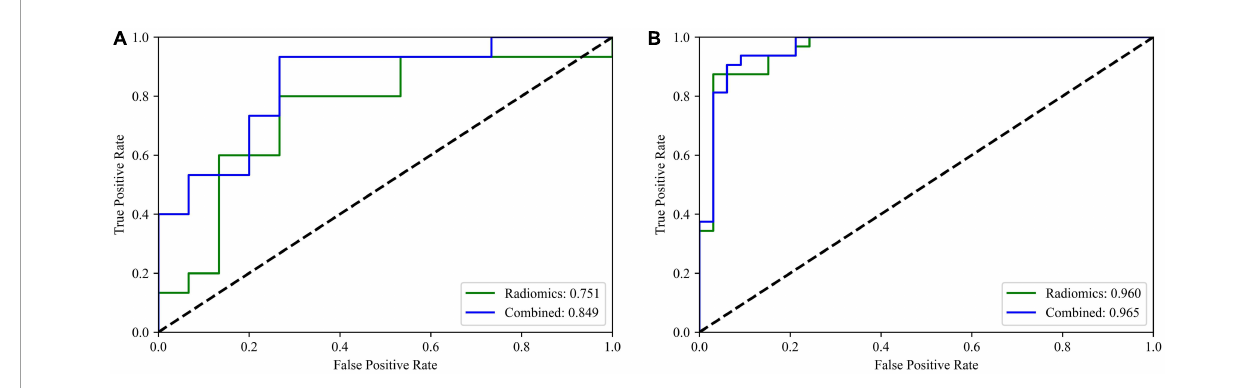
FIGURE2 (A,B) ROC curves of the radiomics and combined model on the testing cohort and training cohort,